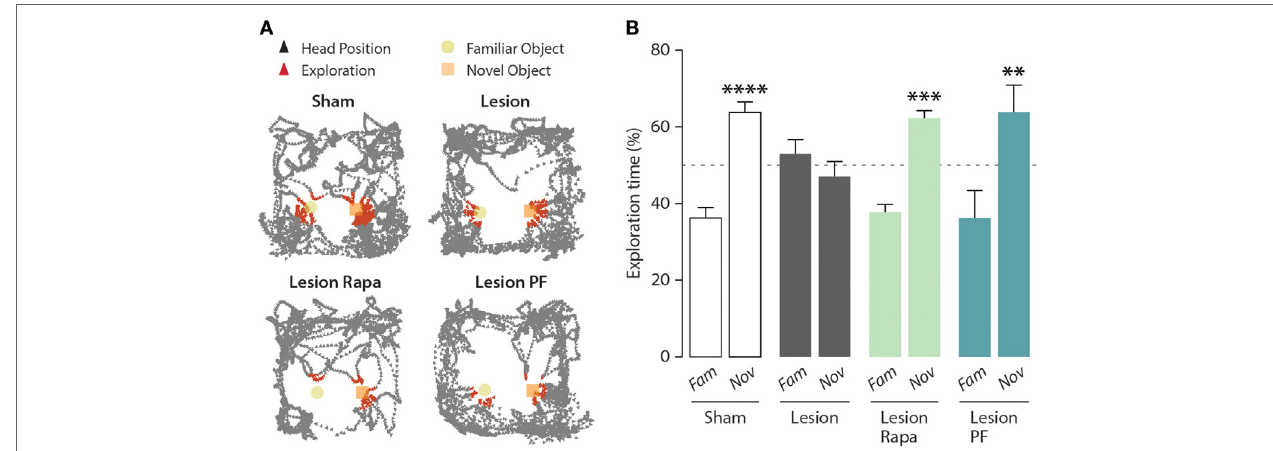
FigUre 1 | Inhibition of mammalian target of rapamycin complex 1, or its downstream target S6 kinase, rescues novel object recognition (NOR) memory in a mouse model of Parkinson’s disease. NOR test performance in control (Sham) mice treated with vehicle ( n = 16), and Lesion mice treated with vehicle ( n = 12), rapamycin (Lesion Rapa, n = 16), or PF-4708671 (Lesion PF, n = 8). (a) Representative traces of mice performing the NOR test. Triangles indicate the head position during the test (in black) and during exploratory behavior (in red). (B) Time spent exploring the familiar (Fam) or novel (Nov) object over a 5 min test. Data are expressed as percent of total exploration time and represented as mean ± SEM. **** p = 0.0001, *** p = 0.0003, and ** p = 0.003 vs. Fam within groups (two-way ANOVA followed by Fisher’s post hoc